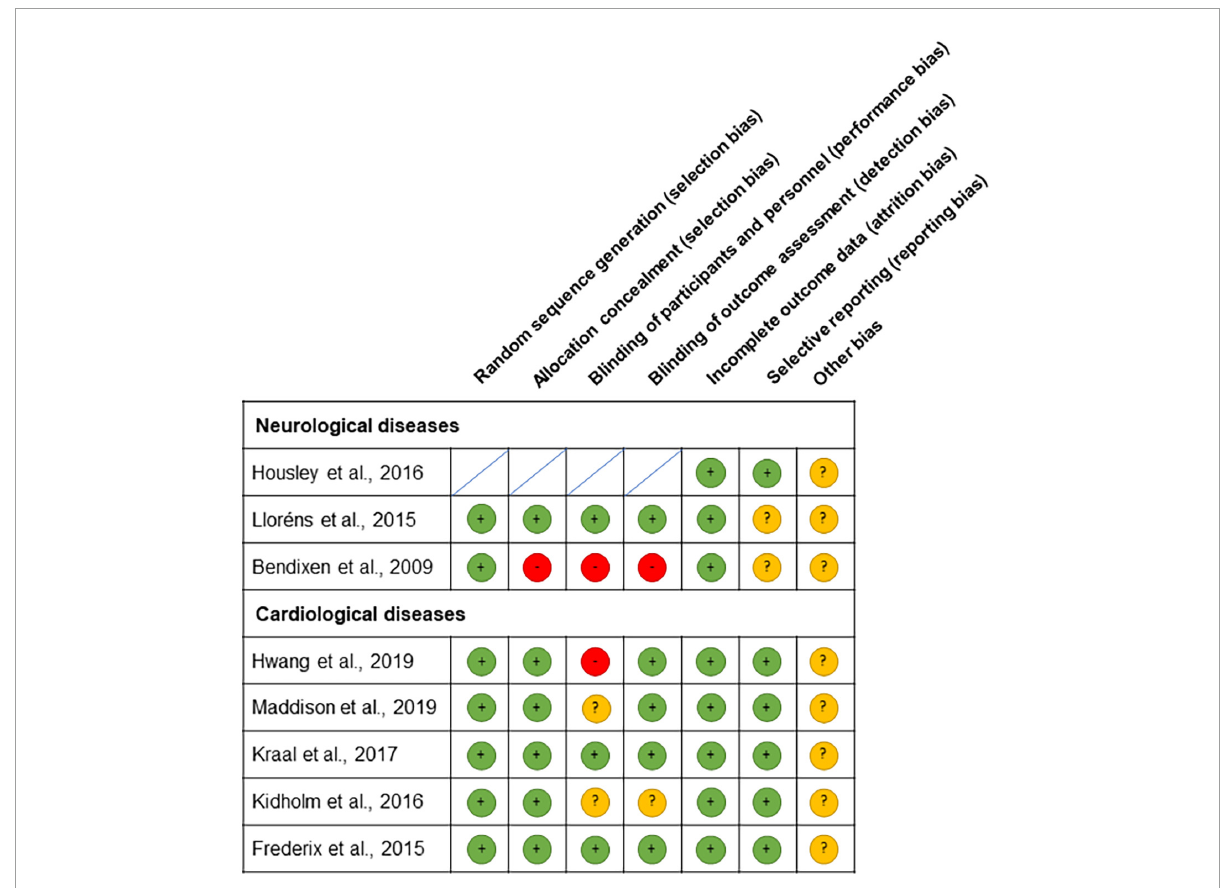
FIGURE2 Risk of bias assessment summary according to the Cochrane’s risk of bias tool: red, green, and yellow colors indicate high, low, and unclear risk of bias,